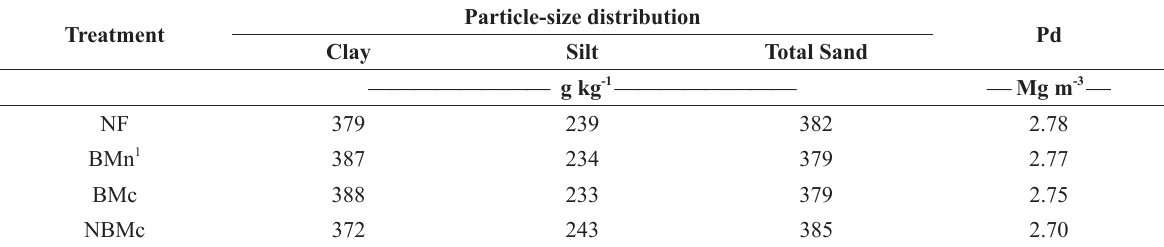
sugarcane harvesting systems.